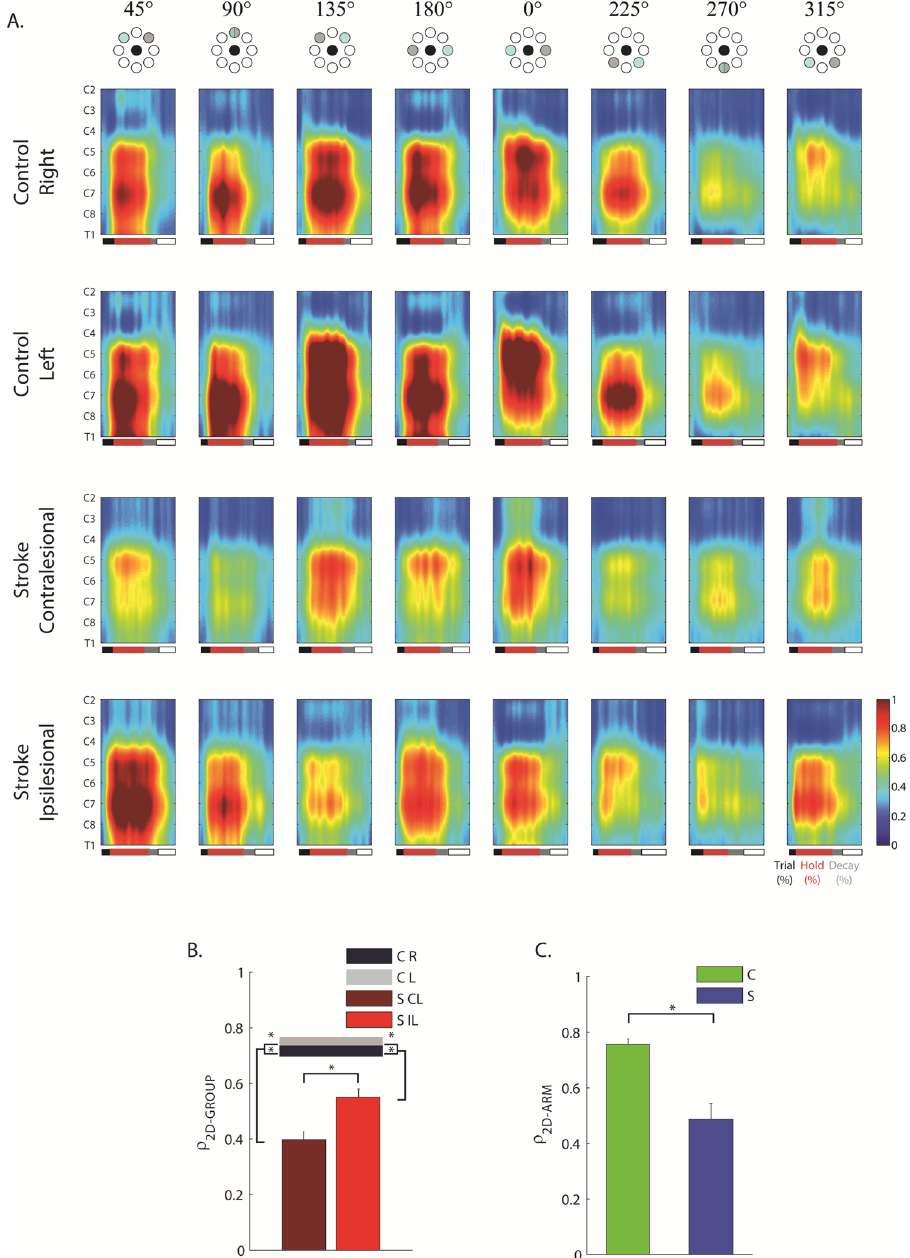
Figure 3. The spinal maps and correlation coefficients of muscle activations. ( A ) The spinal maps during force exertion in the eight directions for the right (first row) and left (second row) arm of a control subject (C) as well as the contralesional (third row) and ipsilesional (fourth row) arm of a stroke subject (S). On the x-axis the duration of the movement is represented in percentage of the total duration. Relative amplitude is denoted by a color scale (right calibration bar, see supplementary material ST II—for more details). Bars to the bottom of maps denote trial-to-release transition time. Muscle activations are referred to equal directions in the joint space; i.e. for each column the top panel indicates the corresponding target directions (cyan target) for the right arm, while the corresponding target directions of the left arm were mirror symmetric with respect to the vertical midline. ( B ) Mean and standard error of the ρ 2D-INTER-GROUP related to the spinal map similarity between control (C) and stroke subject (S) both for contralesional (CL, dark color) and ipsilesional (IL, light color) arm. The black (right arm) and grey (left arm) bars indicate the intra-group similarity (ρ 2D-INTRA-GROUP ), in terms of ρ 2D , between the spinal maps of the control (C) group. Panel C: Mean and standard error of the ρ 2D-ARM related to the similarity between right and left arm of the control subjects (C; green bar) and between contralesional and ipsilesional arm of stroke subjects (S; blue bar). The error bars indicate the standard error of the indicators. * indicates significant differences (p <